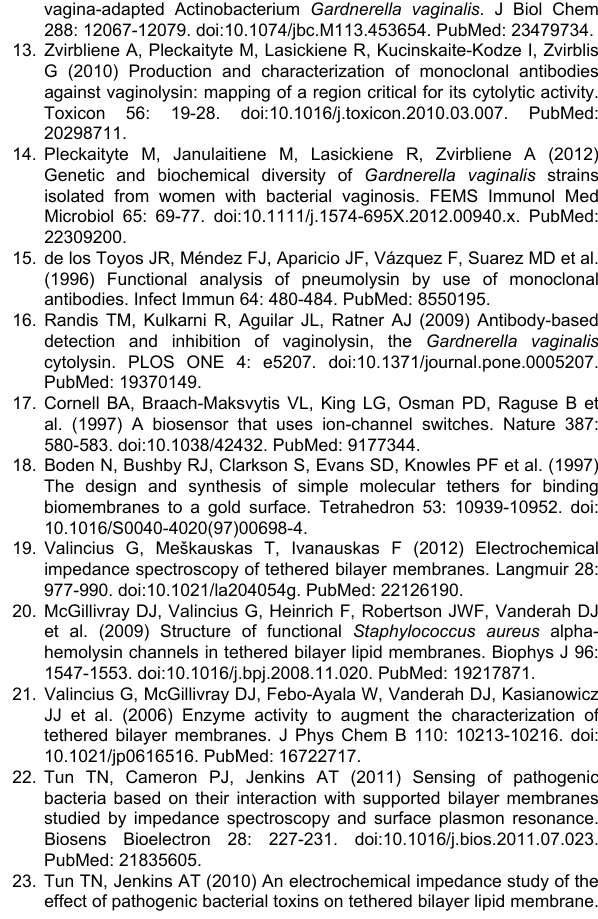
Figure S6. Circular dichroism (CD) spectra of rVLY and its mutants in 20 mM sodium acetate buffer pH 5.5. MRE – mean residue ellipticity.